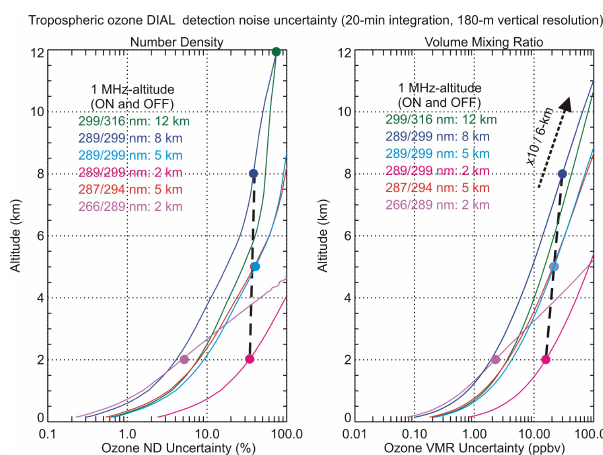
Figure 2. Same as Fig. 1, but for tropospheric ozone systems. This time, integration time is 20min and vertical resolution is 180m. See text for